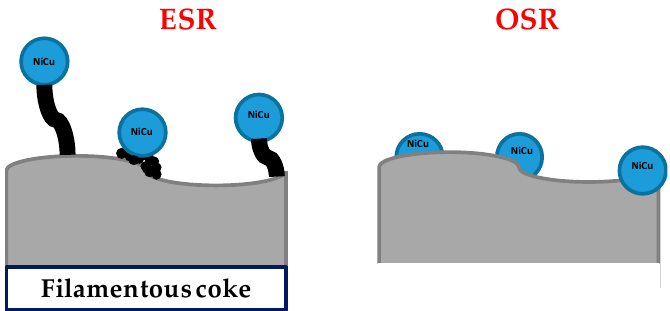
Figure 4. Effects of oxygen addition on carbon formation during ESR for Ni-Cu catalysts derived from hydrotalcite-like compounds [59].